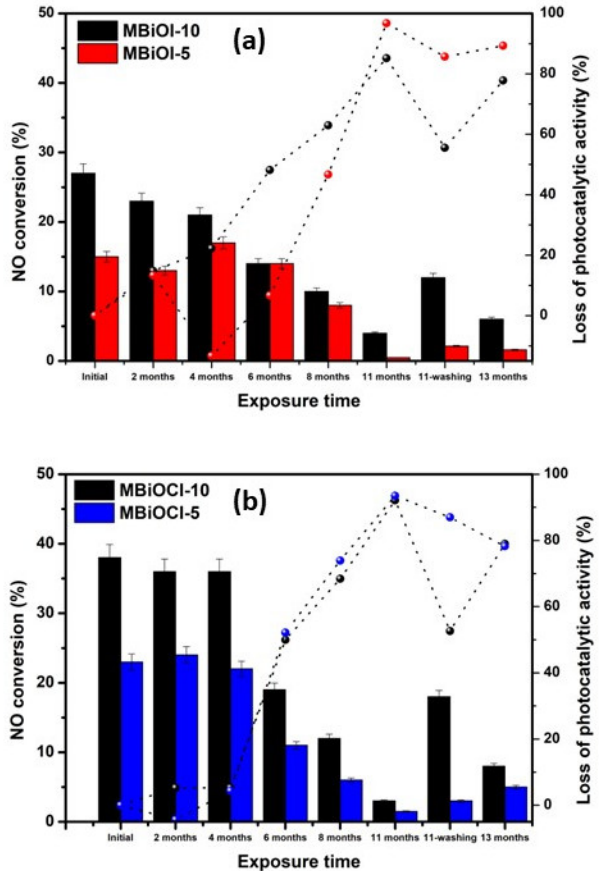
Figure 9. NO removal (bars) and loss of photocatalytic activity (lines) of mortar samples exposed to outdoor weathering during 1-year: ( a ) MBiOI-5 and MBiOI-10 and ( b ) MBiOCl-5 and MBiOCl-10.